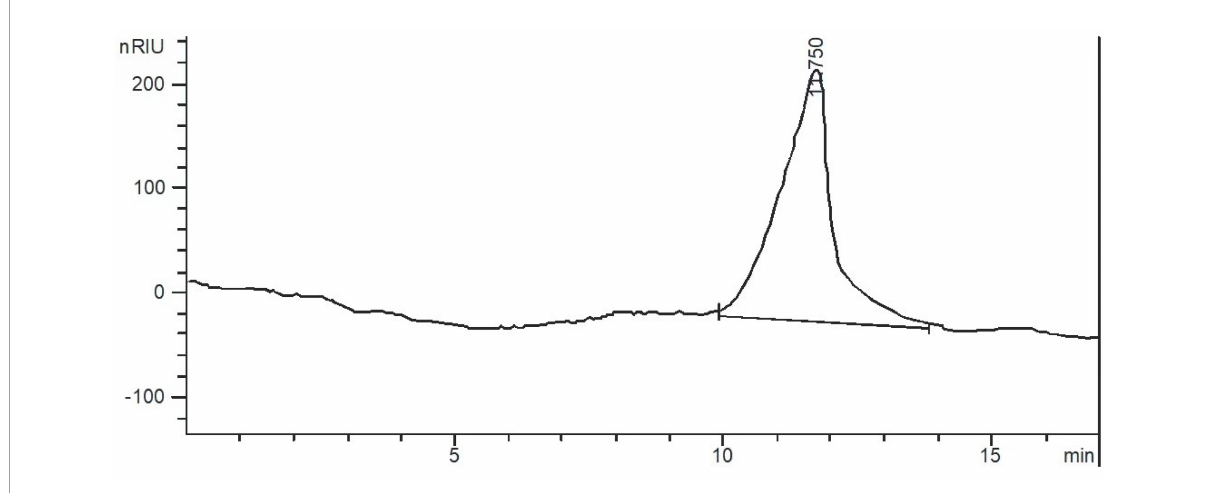
FIGURE2 High performance gel permeation chromatogram (HPGPC) of Sparassis latifolia neutral polysaccharides SLNP.